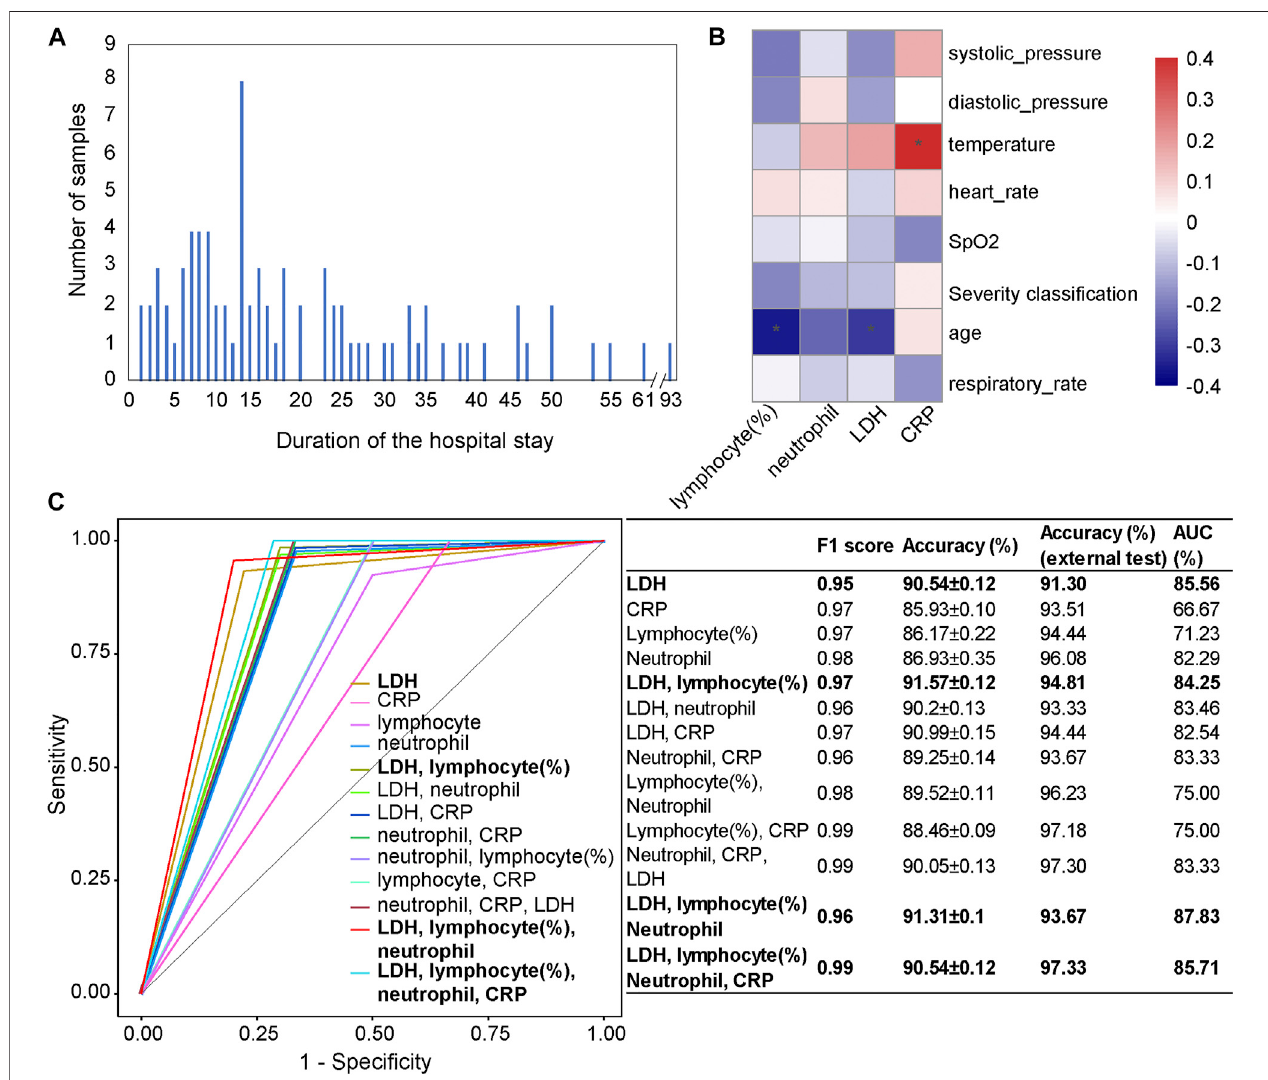
FIGURE5| IndependenttestresultsontheWürzburgcohortutilizingthe fi rstsamplesatadmission. (A) Thenumberofpatientscategorizedbytheirdurationofthe hospital stay. (B) The associations between clinical features (LDH, CRP, lymphocyte (%), and neutrophil count) and phenotypic characteristics. (C) Comparison of receiver operating characteristic (ROC) curves and diagnostic performance of four clinical features, the combinations of a subset of features, as well as each selected single feature, using the fi rst samples at admission. Note: * represents a signi fi cant correlation between a phenotypic characteristic and a clinical feature (Pearson correlation: p <